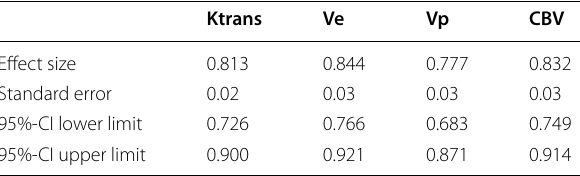
Table 2 Combined effect size for the different DCE/DSC